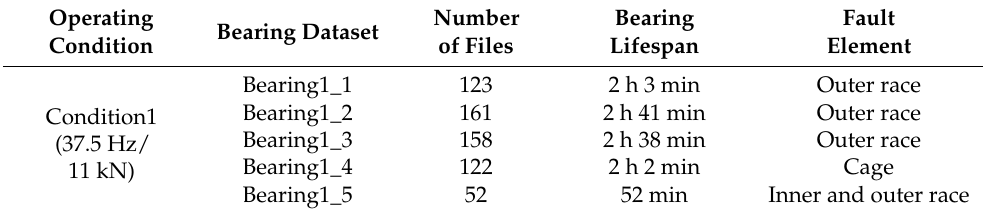
Table 2. XJTU-SY bearing